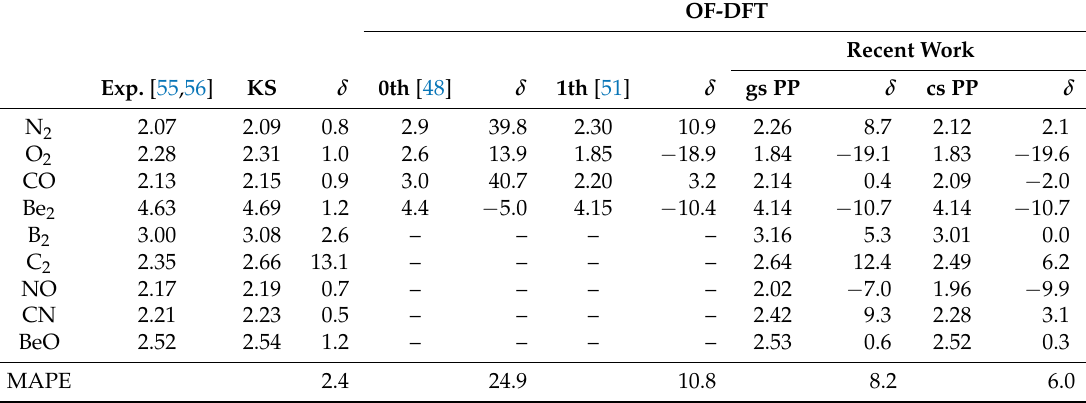
– – – − 9.9 CN 2.21 – – – – BeO 2.52 2.54 1.2 – – – – 0.3 MAPE